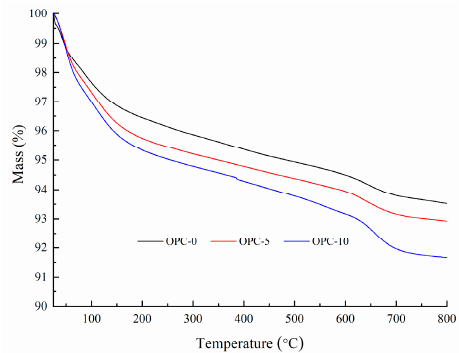
Figure 4. The percentage of mass loss at elevated temperatures.